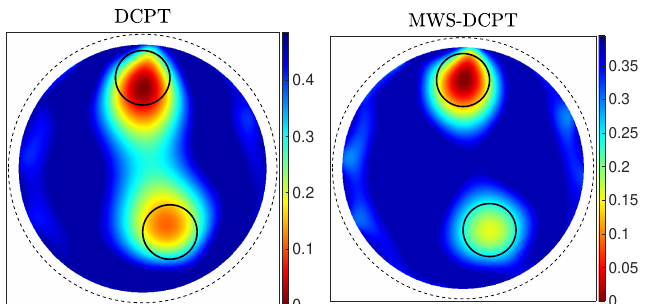
Figure 8. Reconstructed image of air bubbles dispersed in oil. The admittance data for the reconstruc- tion were obtained using finite element simulations. Further details can be found in